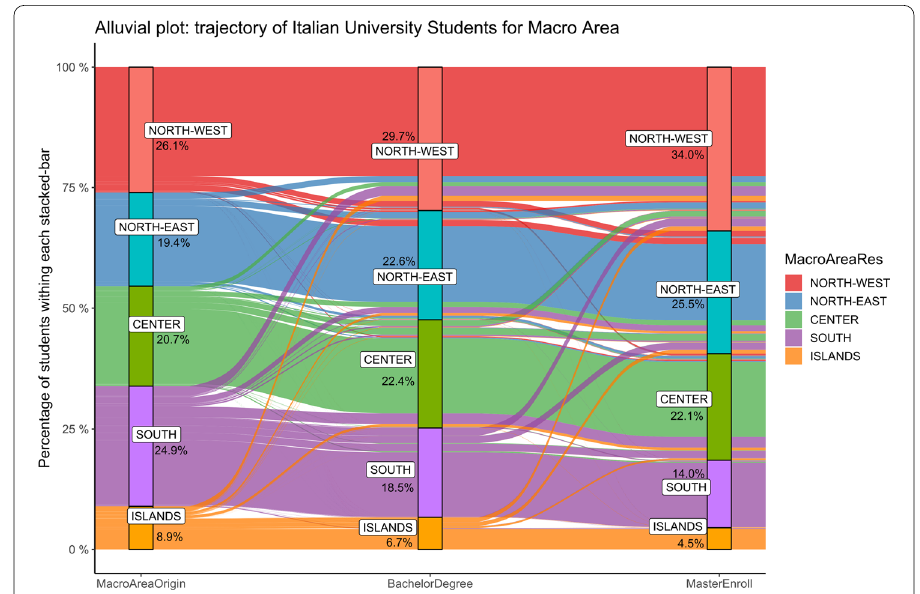
Fig. 1 Italian students’ flows according to residence, bachelor and master degree territorial